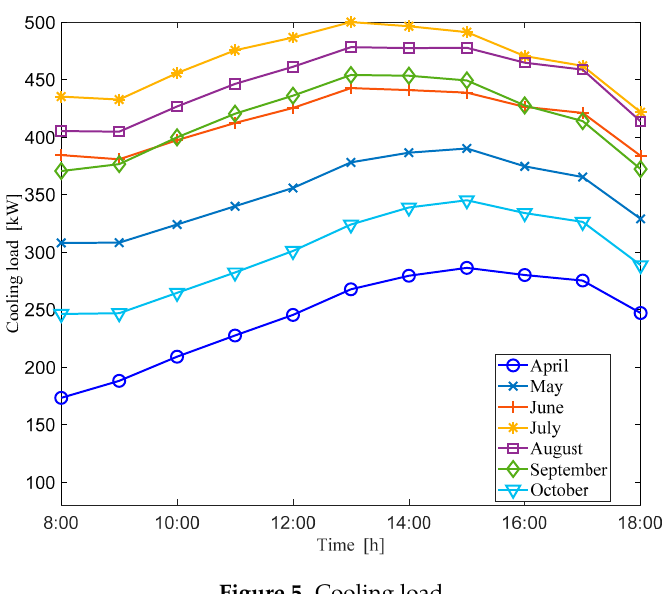
Figure 4. Ambient temperature.